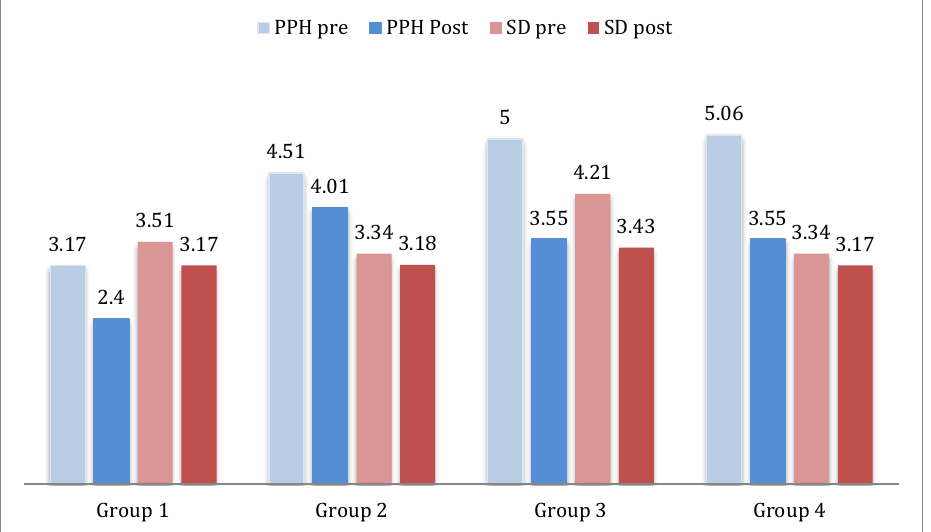
Figure 3. Overall time to resolution in minutes of the postpartum hemorrhage and shoulder dystocia simulations. PPH: Postpartum Hemorrhage, SD: Shoulder Dystocia